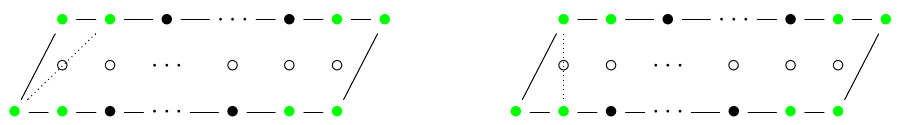
Figure 6 . Computation of the defect group for the (SU(2) 0 ) N theory: all the allowed triangles have twice the minimal area. Here we draw two of the four allowed triangles — the other two are the symmetric ones, on the other side of the